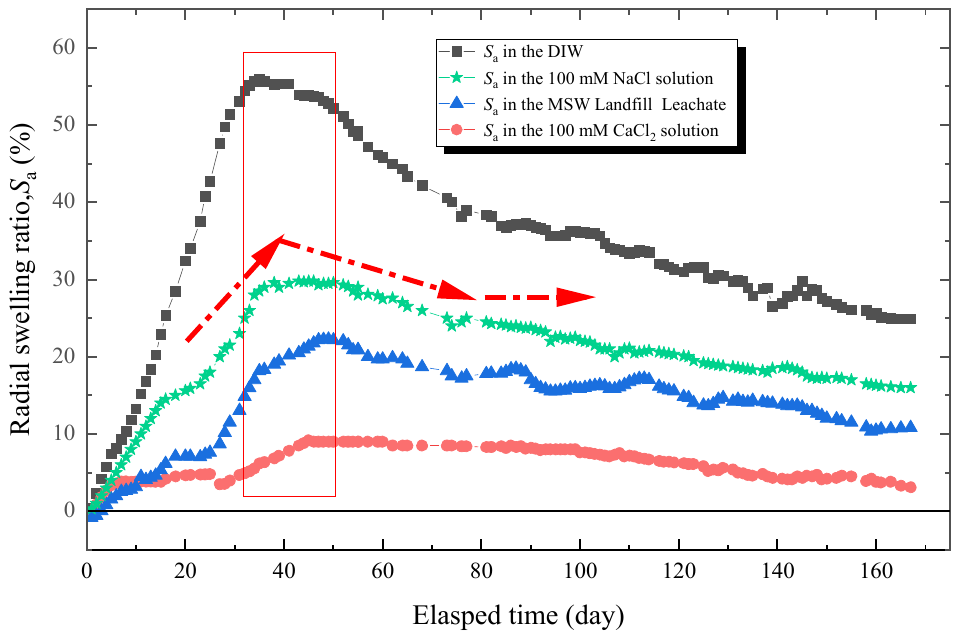
Figure 6. The radial swelling test results of specimens with different testing